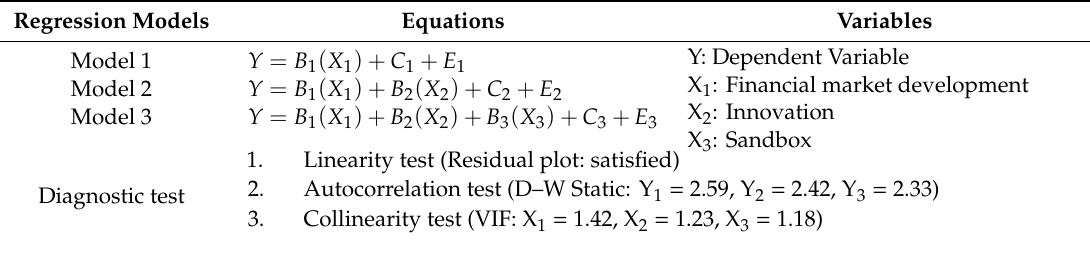
Table 5. The detailed regression